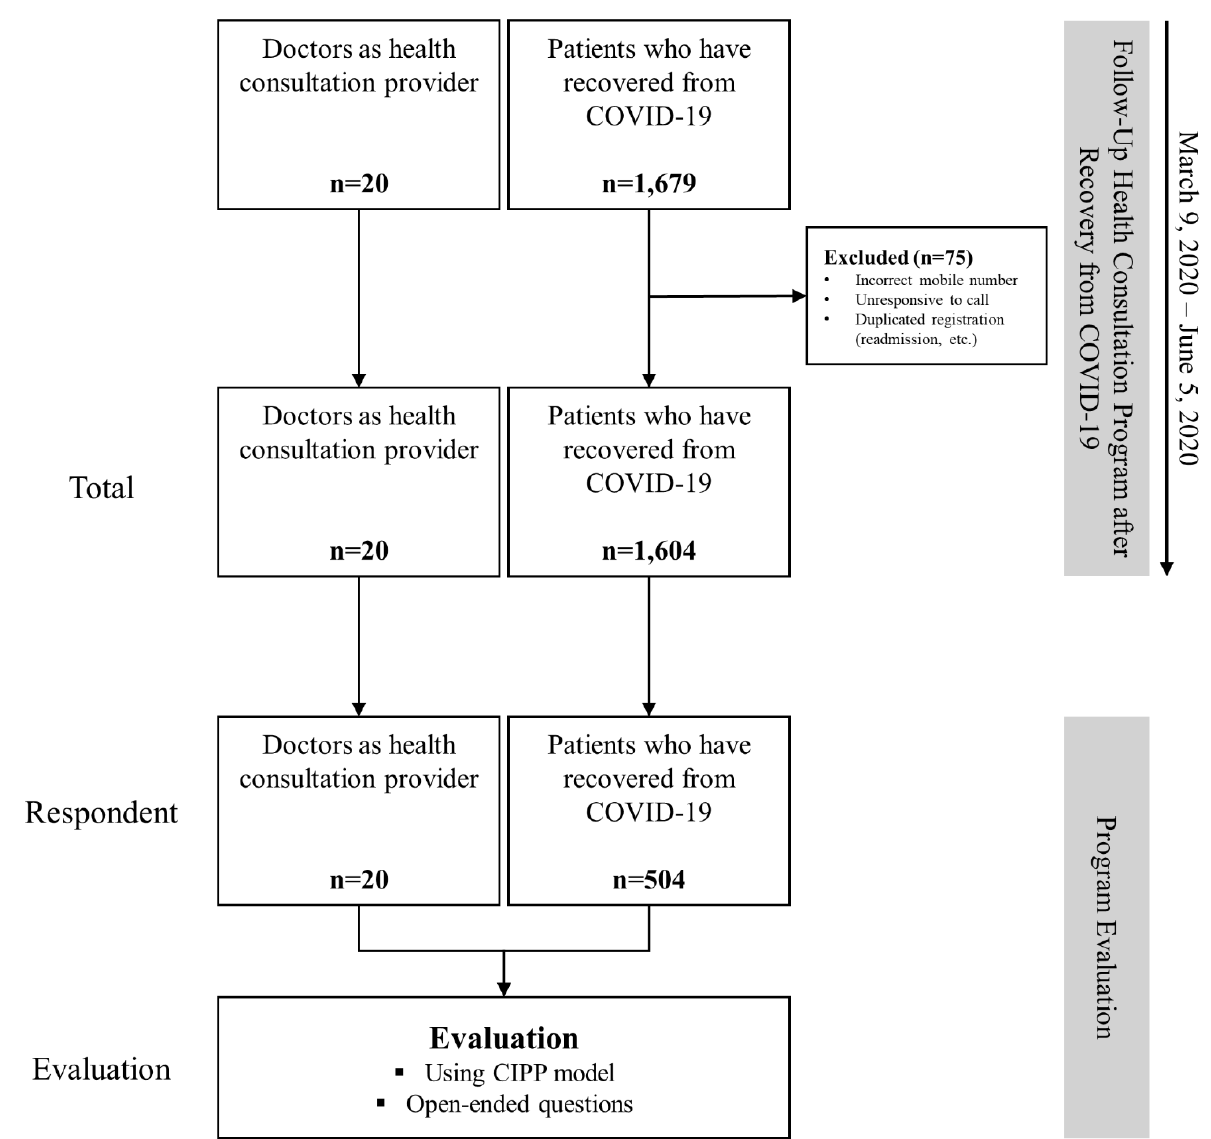
Figure 1. Flowchart of the study. A survey was conducted for program evaluation of 20 doctors and 1604 patients who participated in the Follow-Up Health Consultation Program. All 20 doctors (100%) and 504 of the 1604 patients (31.4%) responded to the questionnaire. COVID-19: coronavirus disease 2019; CIPP: Context – Input – Process – Product.